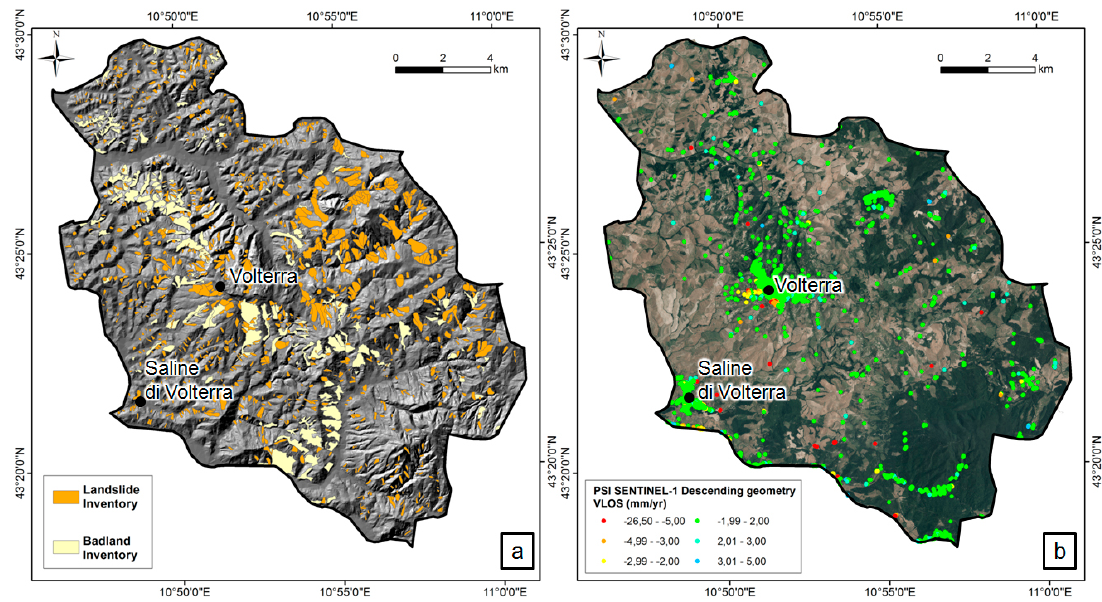
Figure 3. ( a ) Landslide inventory map and badland inventory maps. Background layer is a DEM (Digital Elevation Model) with 20 m cell size extracted from TINITALY/01 DEM Project [40]. The